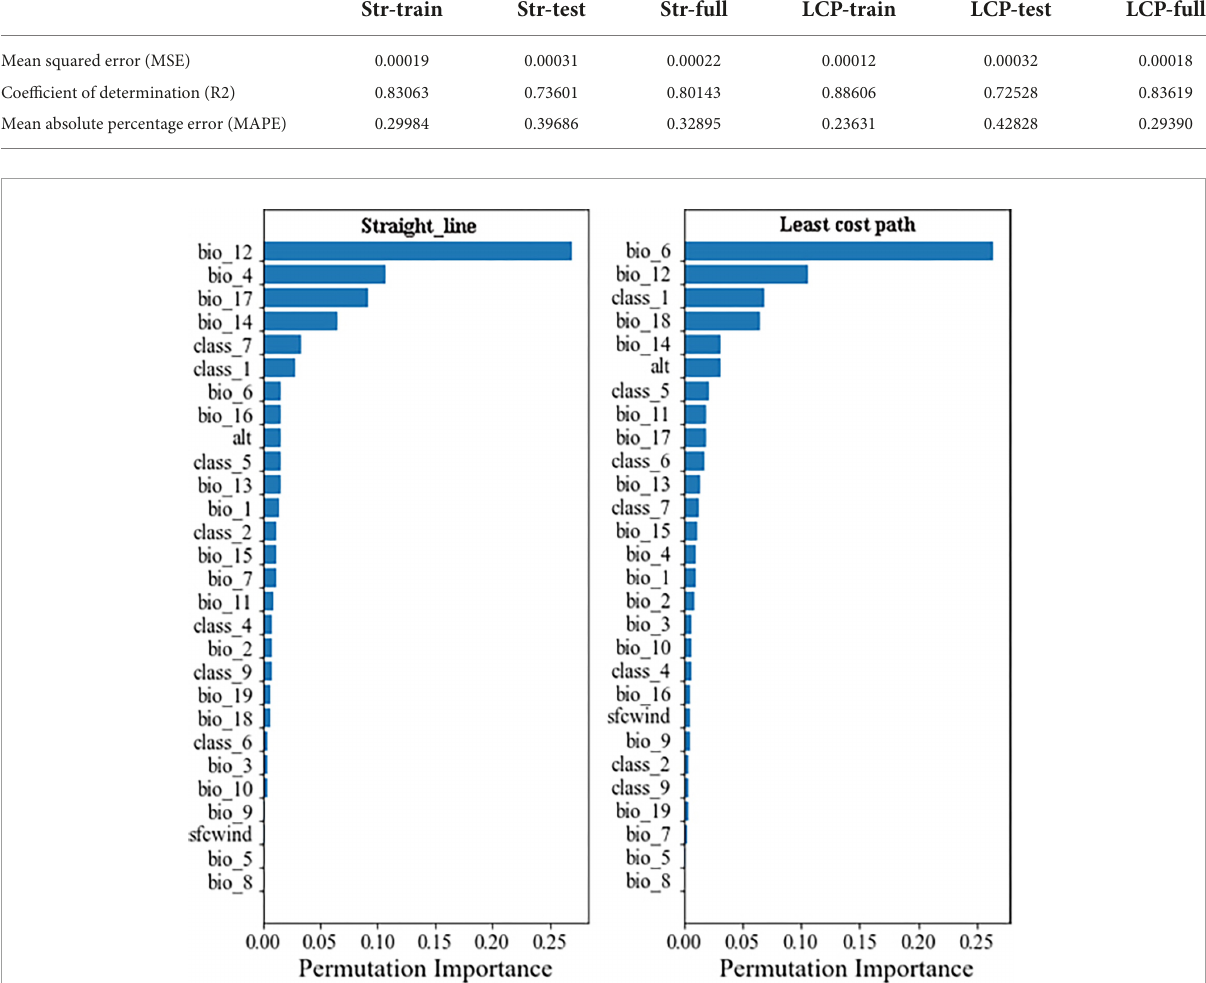
A R , H e , and H o ). At the 1,000 and 2,000-m radius